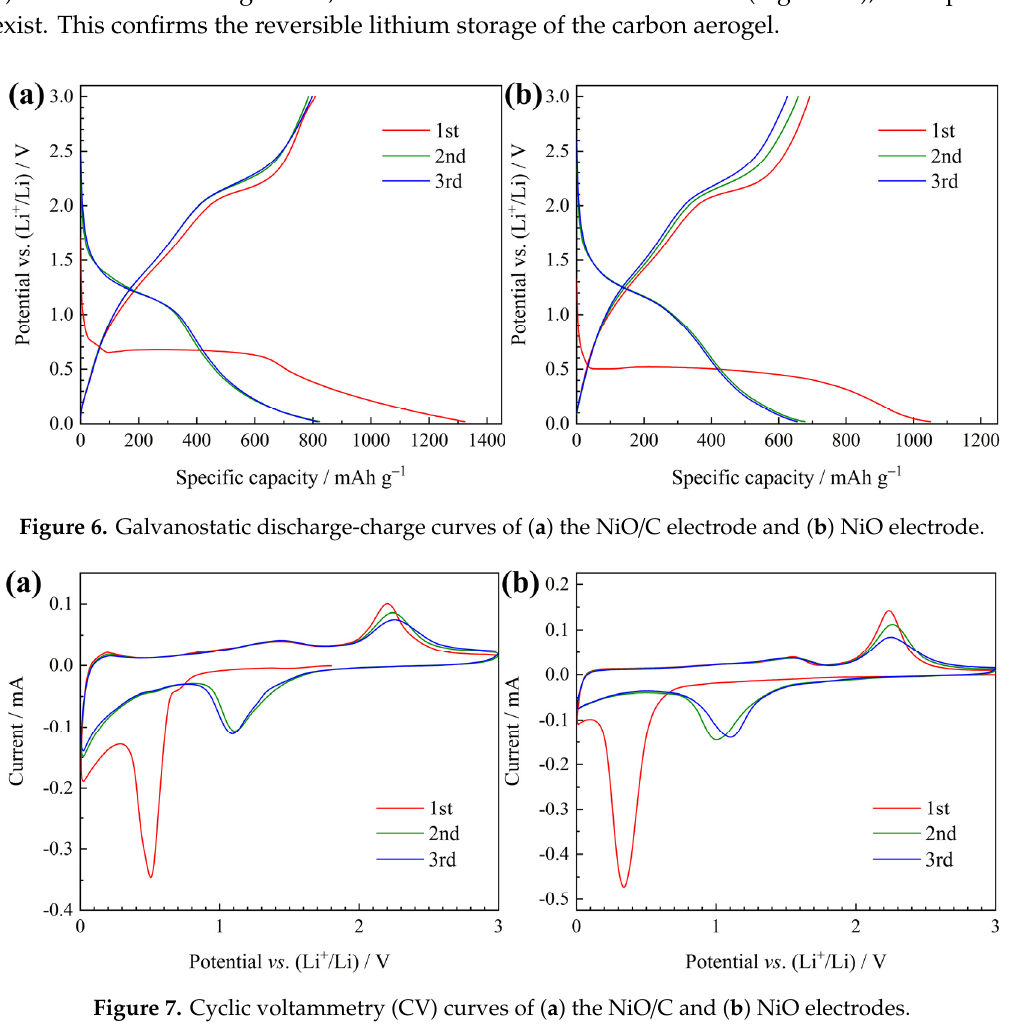
Figure 8. Comparison of ( a ) cycling performance and ( b ) coulombic efficiency between the two electrodes.